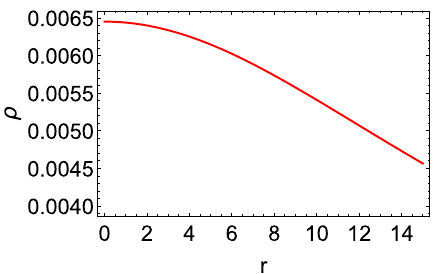
Fig. 1 Variation of density with radial